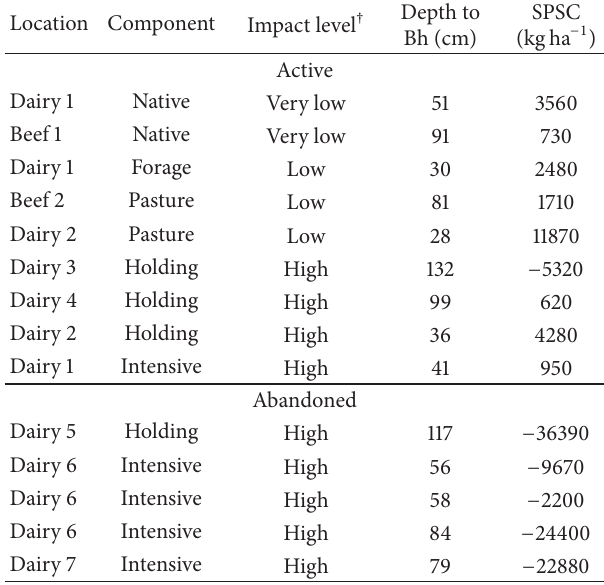
Table 1: Phosphorus concentrations in rainfall simulation † lea- chates for each P source for three simulations conducted at 1-week intervals.